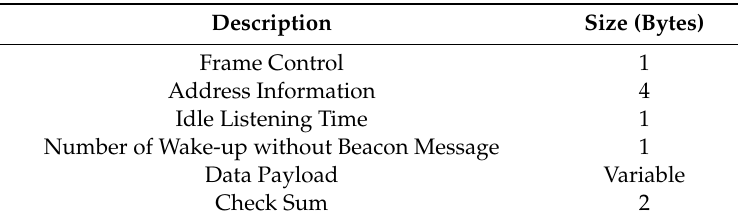
Table 1. Control Frame Message (send by transmitter